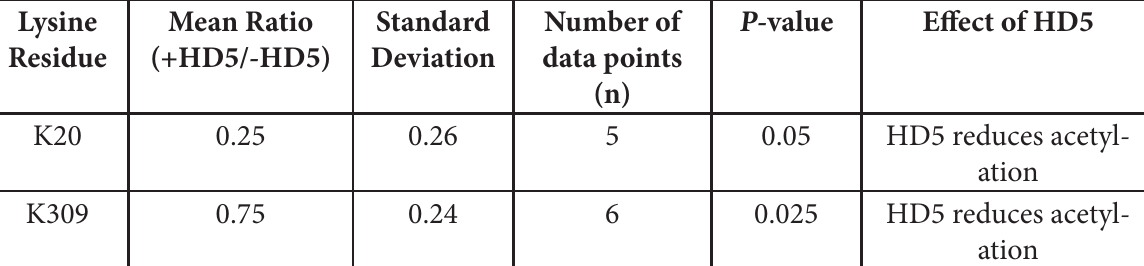
Table 3. Mass spectrometry detected lysine acetylation sites of L2 protein affected by the presence of